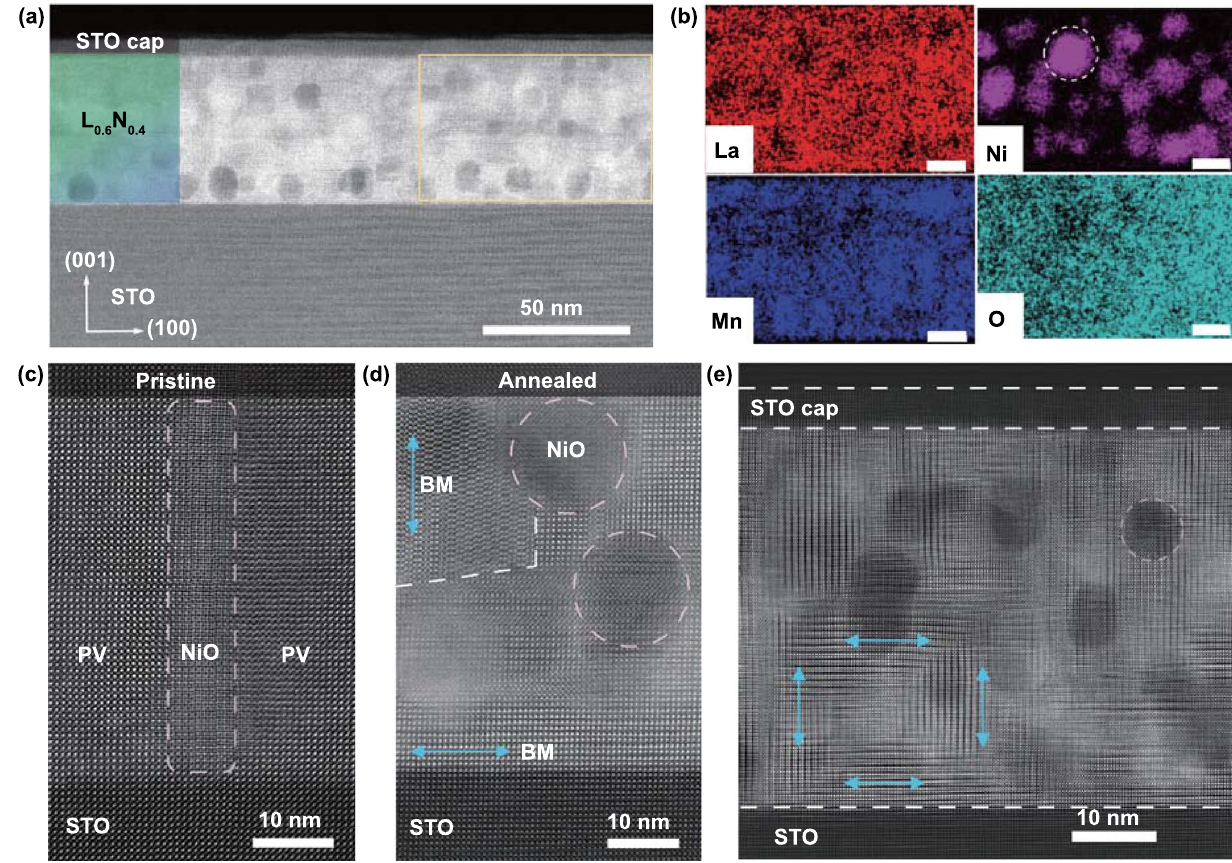
Fig. 3 a Cross-sectional low-magnification HAADF-STEM image and b element-specific EDS maps of a vacuum-annealed STO/L 0.6 N 0.4 film identifying the formation of NiO nanograins distributed throughout the film. Atomic resolution STEM images of c as-grown PV L 0.6 N 0.4 film showing a vertical NiO nanopillar running through the PV film and d vacuum-annealed STO/L 0.6 N 0.4 film showing NiO nanograins, BM phase segments with perpendicular OVC directions indicated by the light blue arrows and residual PV phase segments. e STEM image divided into several regions by white dashed lines. The orientations of BM domains are marked by light blue arrows, and the shape of NiO is highlighted by pink dashed